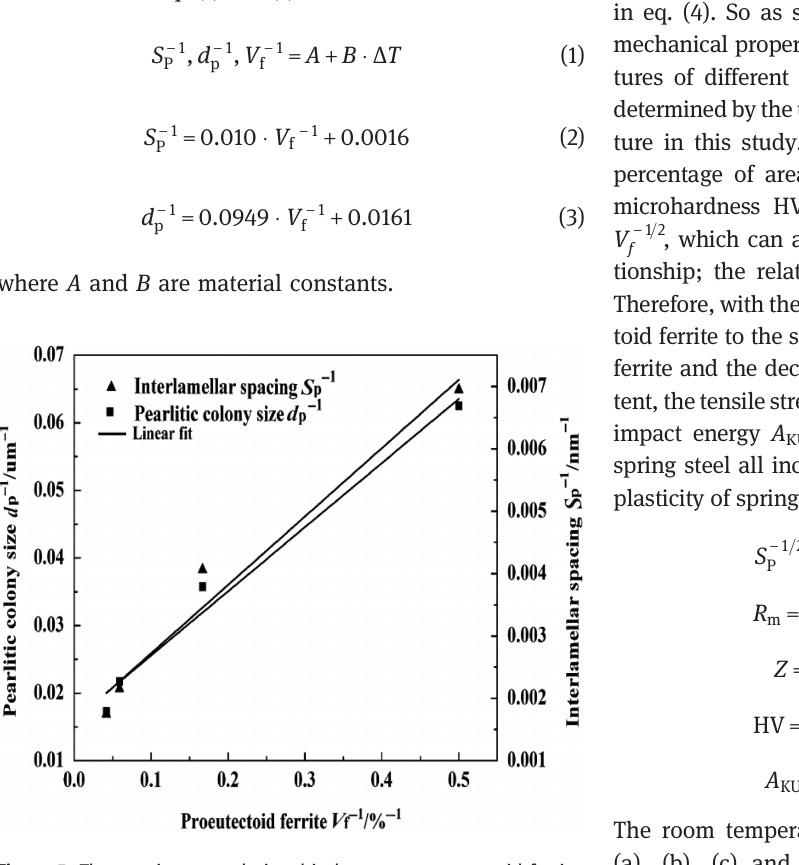
Figure 5: The coexistence relationship between proeutectoid ferrite and pearlite.